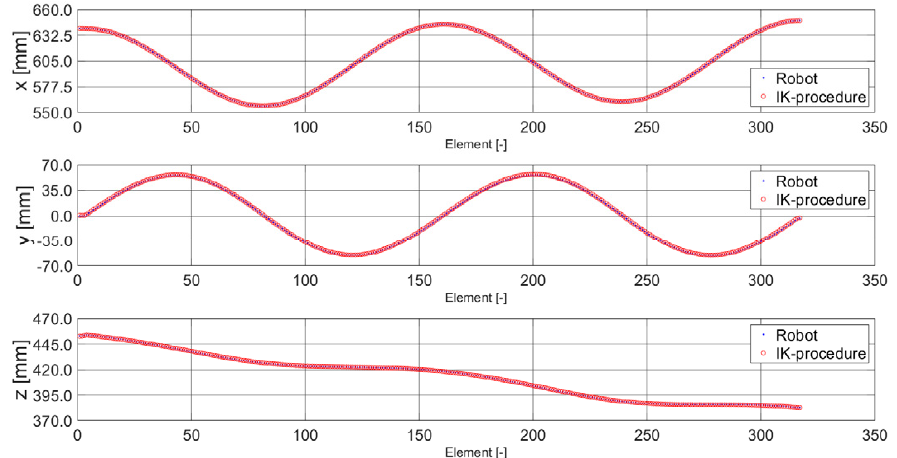
Figure 15. Spiral along Z-axis: X-, Y-, Z-axes Robot vs. IK procedure.